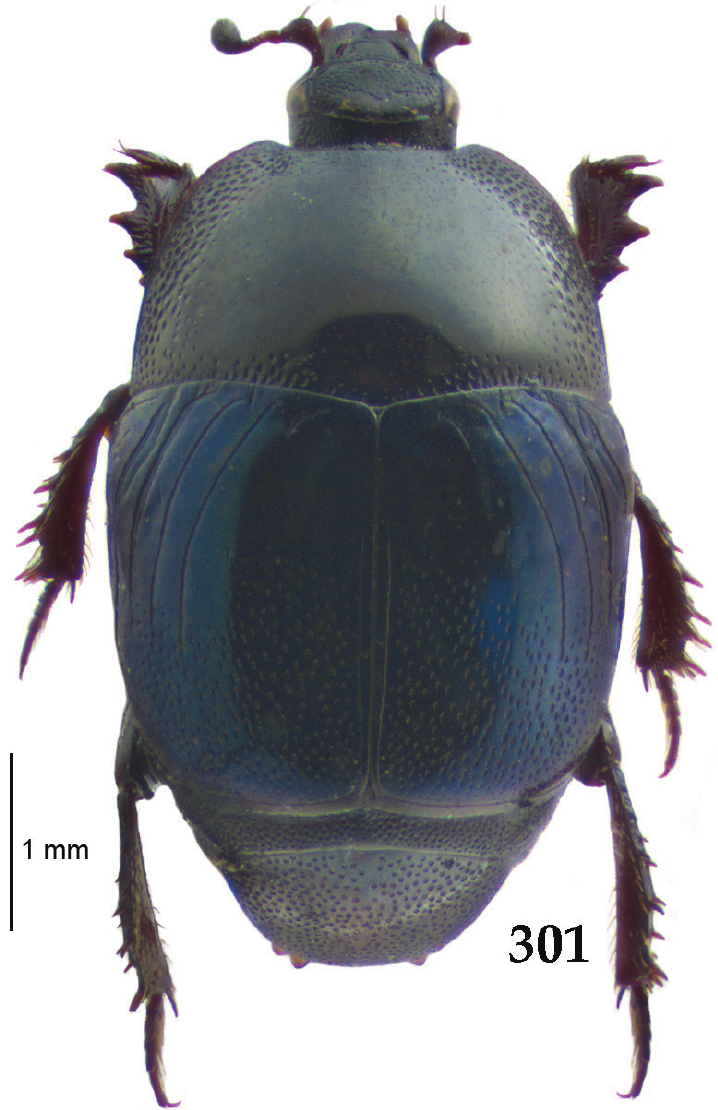
Figure 301. Saprinus ( Saprinus ) amethystinus Lewis, 1900 habitus, dorsal view. Re-description. Body length: PEL: 3.25–3.85 mm; EL: 2.00–2.40 mm; APW: 1.25–1.60 mm; PPW: 2.25–2.75 mm; EW: 2.50–3.00 mm. Body (Fig. 301) rectangular oval, dorsally convex, ventrally rather flattened; cuticle dark brown, shining, pronotum darker, piceous black, with bronze metallic luster; elytra on basal third light brown, rest of elytra darker, elytra with dark blue metallic luster; legs, mouthparts and antennal scape castaneous brown; antennal club light